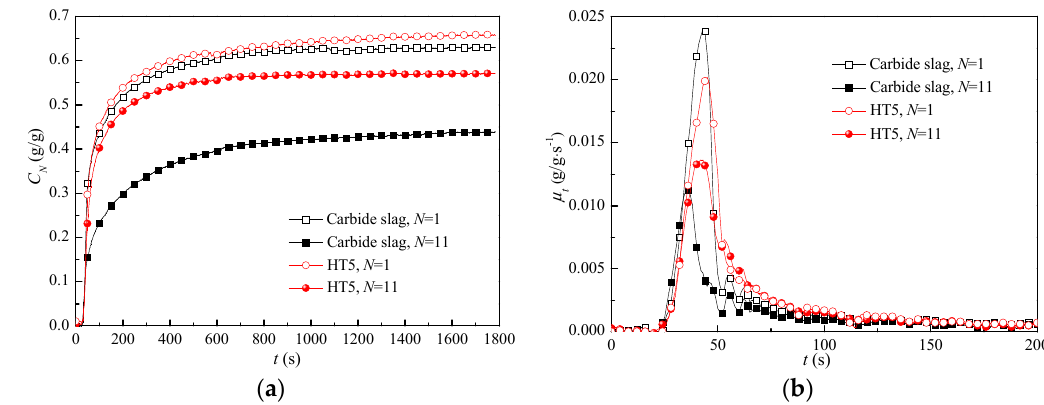
Figure 9. Apparent CO 2 capture kinetics of HT5 tested on thermo-gravimetric analyzer (TGA): ( a ) CO 2 capture capacities and ( b ) apparent CO 2 capture rates (carbonation in 15% CO 2 /N 2 at 700 °C for 20 min, calcination in 100% N 2 at 850 °C).